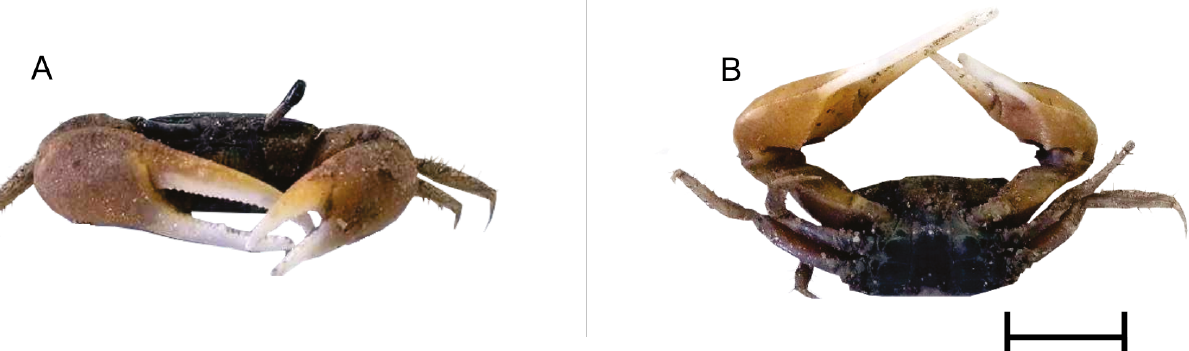
Figure 1. Male of Minuca rapax presenting bilateral hypertrophy in chelae, captured near to Jaguaribe municipality, northern region of Itamaracá Island, Pernambuco, Brazil. A, frontal view; B, ventral view with the smaller cheliped in front. Scale bar: 10